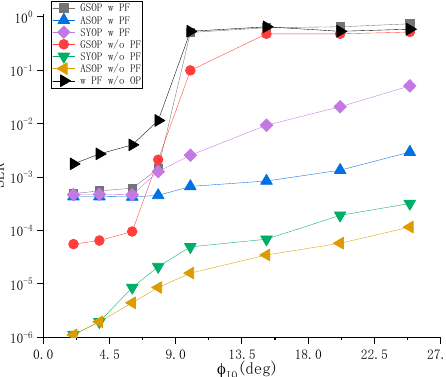
Figure 10. SER versus φ IQ with phase estimation under weak turbulence for C n2 = 1.5 × 10 − 15 m − 2/3 . OP: orthogonalization procedure; PF: phase fluctuation; W: with; W/O: without.